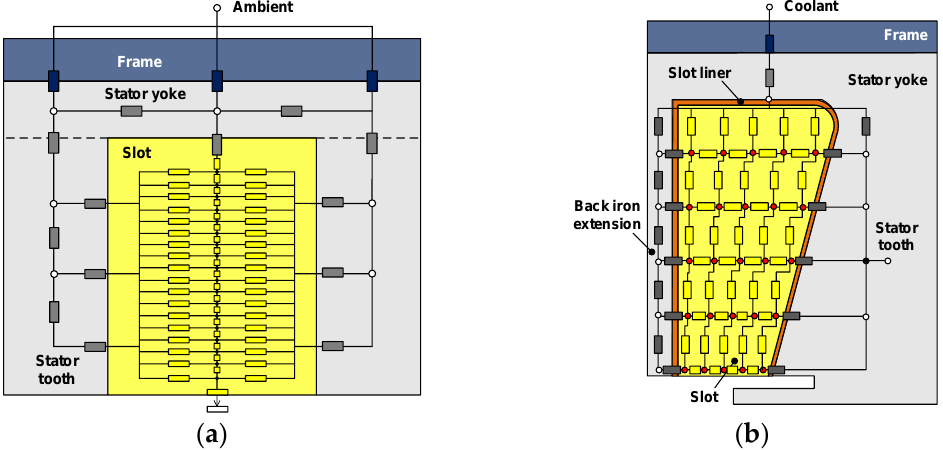
Figure 21. Local discretised LPTM for active-winding. ( a ) Considering ac cooper loss [204]. ( b ) Considering back-iron extension [206].